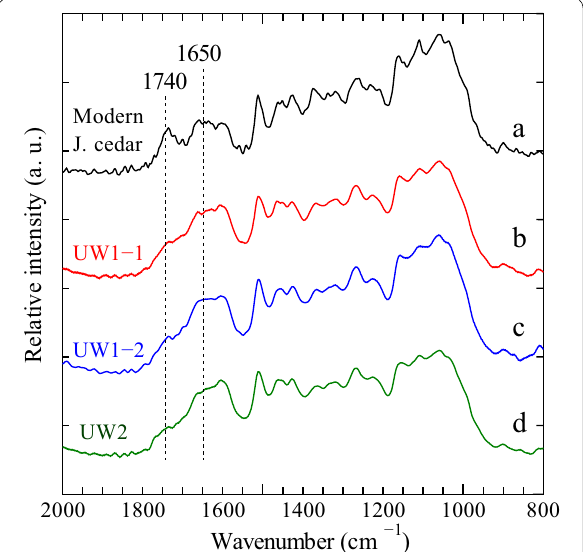
Fig. 3 Infrared photoacoustic spectra in the 2000–800 cm − 1 region for (a) modern Japanese cedar (heartwood, black solid line ), (b) UW1-1 (heartwood, red solid line ), (c) UW1-2 (sapwood, blue solid line ), and (d) UW2 (heartwood, green solid line